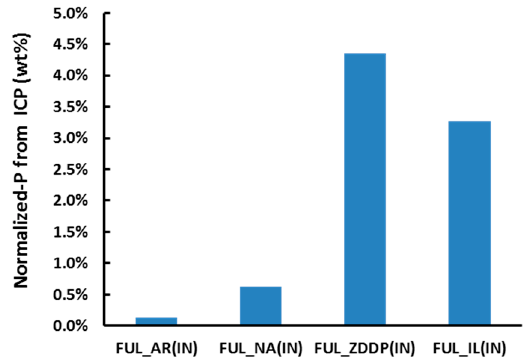
Figure 6. Inductively coupled plasma mass spectrometry (ICP ‐ MS) results for P concentration (normalized to Pd content).